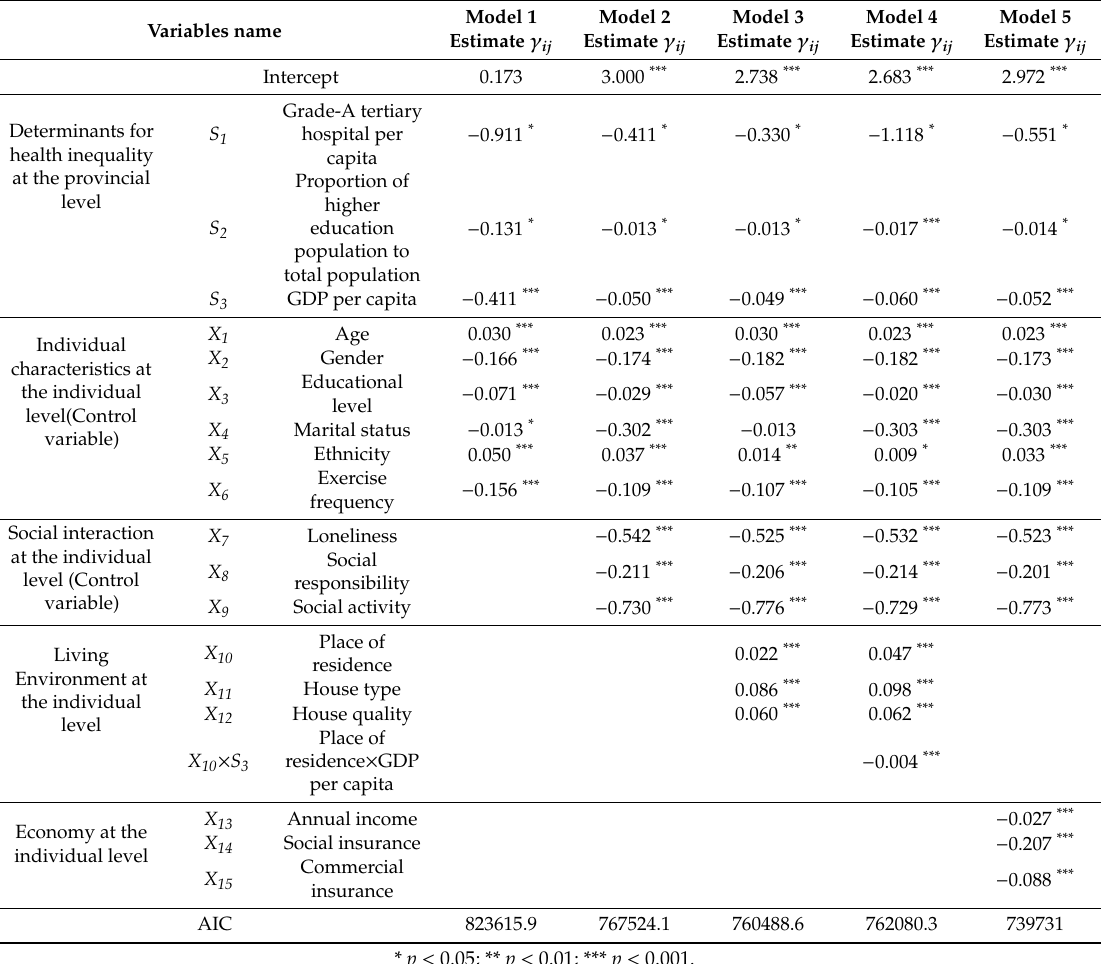
Table 4. Determinants of health inequality.